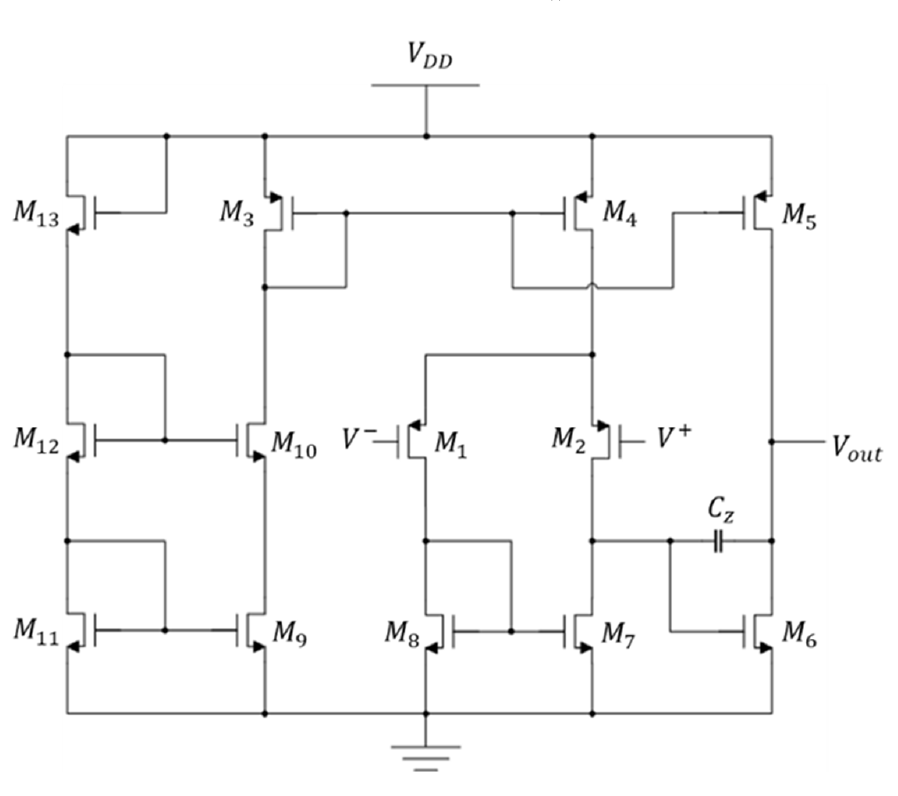
Figure 3. Schematic of the designed operational amplifier (op − amp).